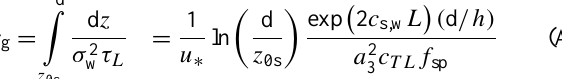
Temperate eucalyptus Cool temperate/warm woody forest/plantation temperate/mediterranean